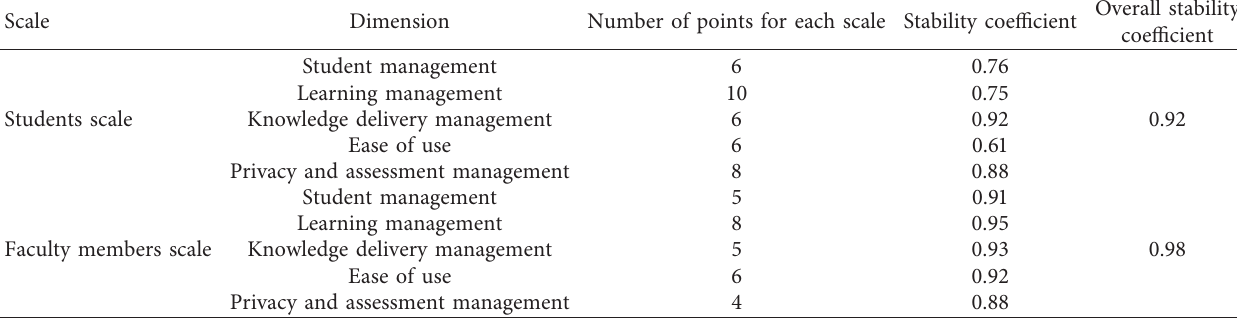
Table 3: Cronbach’s alpha stability coefficient results.